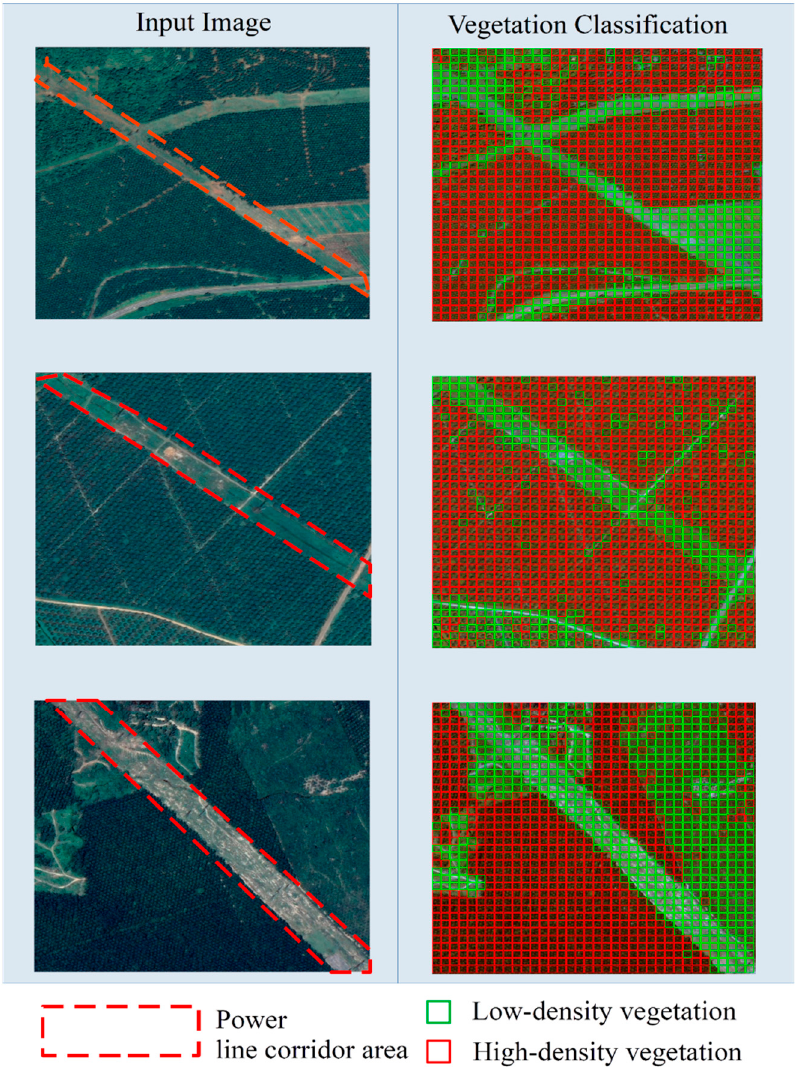
Figure 13. Examples of the vegetation density classification results along the power line corridor area with a patch size of 32 × 32-pixels and step size of s = 4. The red regions represent high-density vegetation and the green regions represent low-density vegetation.